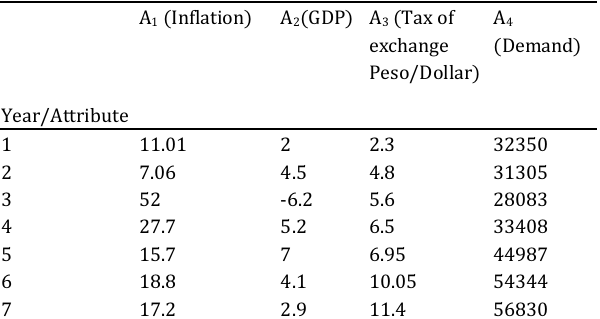
Table 4. Comparison of the truth value of the predicate p for the two first years in Table 3 and with two compatible logic systems: Probabilistic and